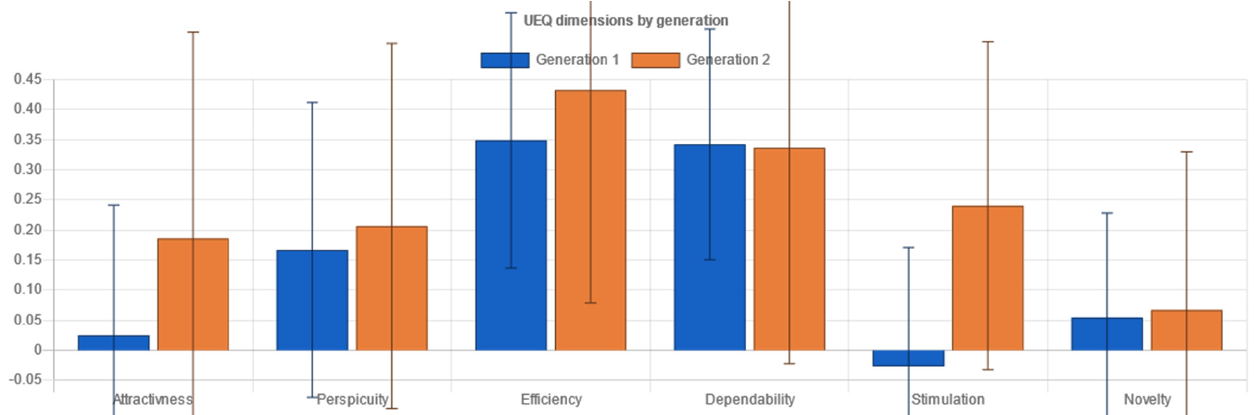
Figure 15. UEQ dimensions by generation.